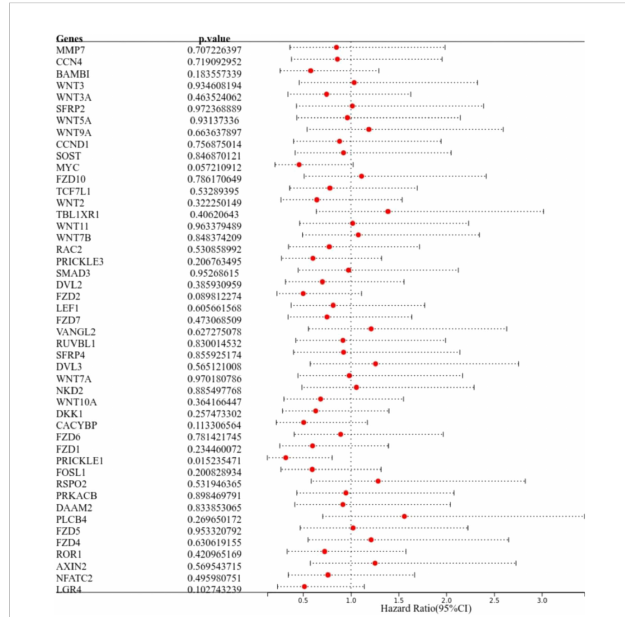
FIGURE 2 Identi fi cation of prognosis-related genes. The forest plot shows PRICKLE1 as a prognosis-related Wnt signaling pathway